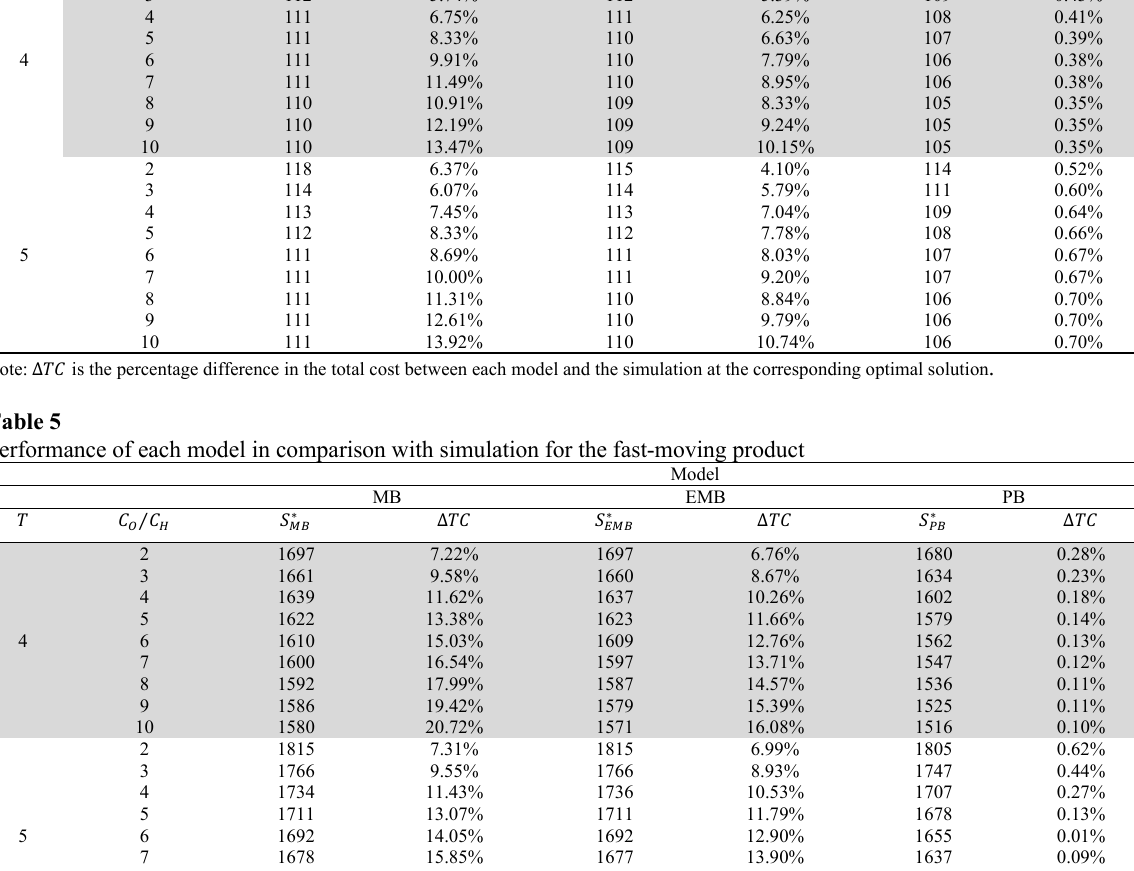
Performance of each model in comparison with simulation for the slow-moving product Model MB EMB PB 𝑇